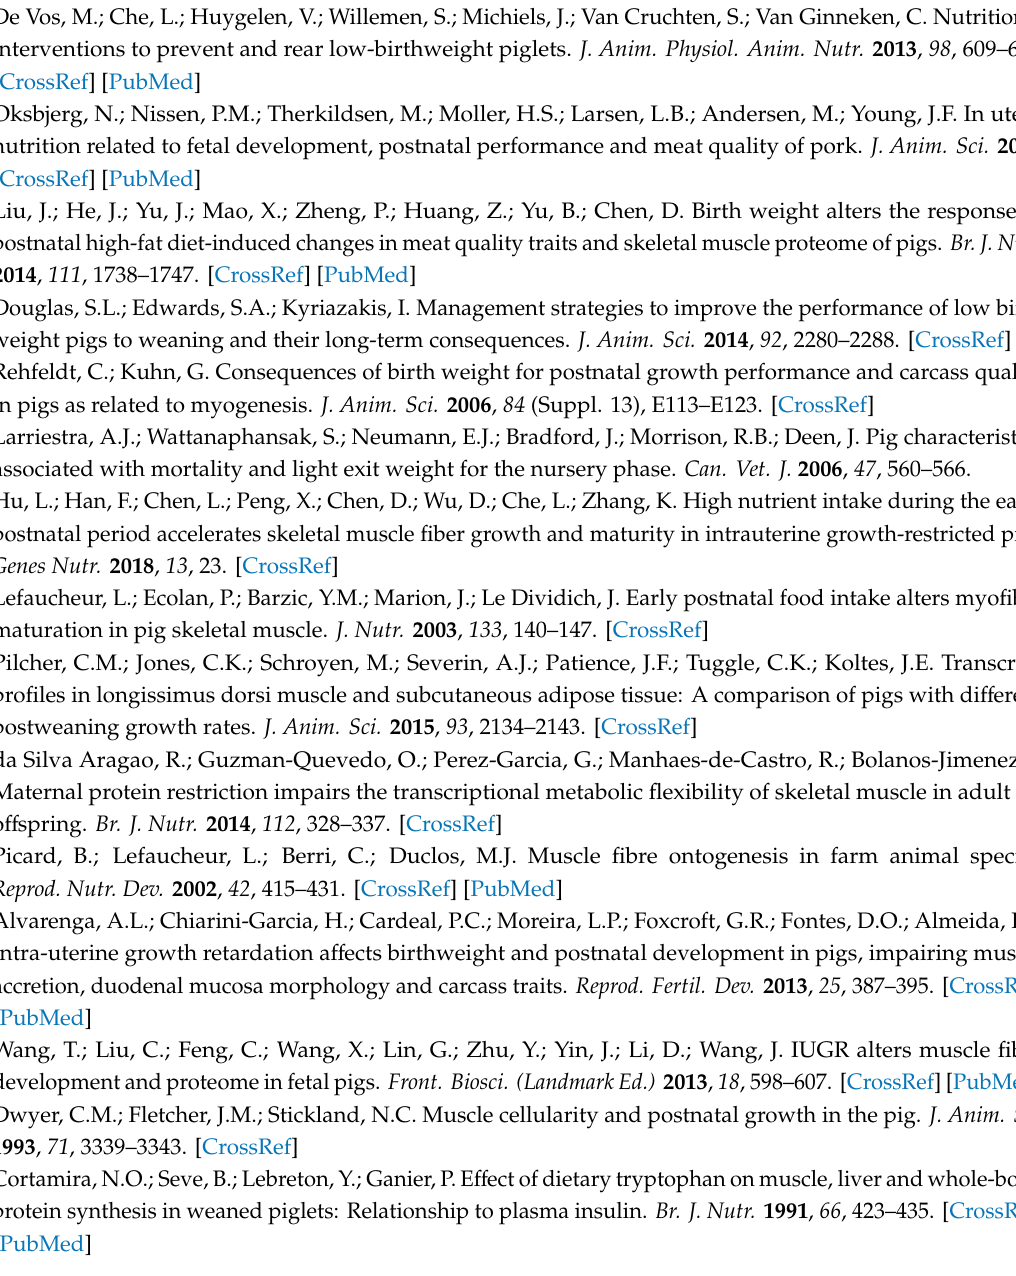
Table S1: Composition and nutrient level of the basal formula milk powder (87.5% DM basis,